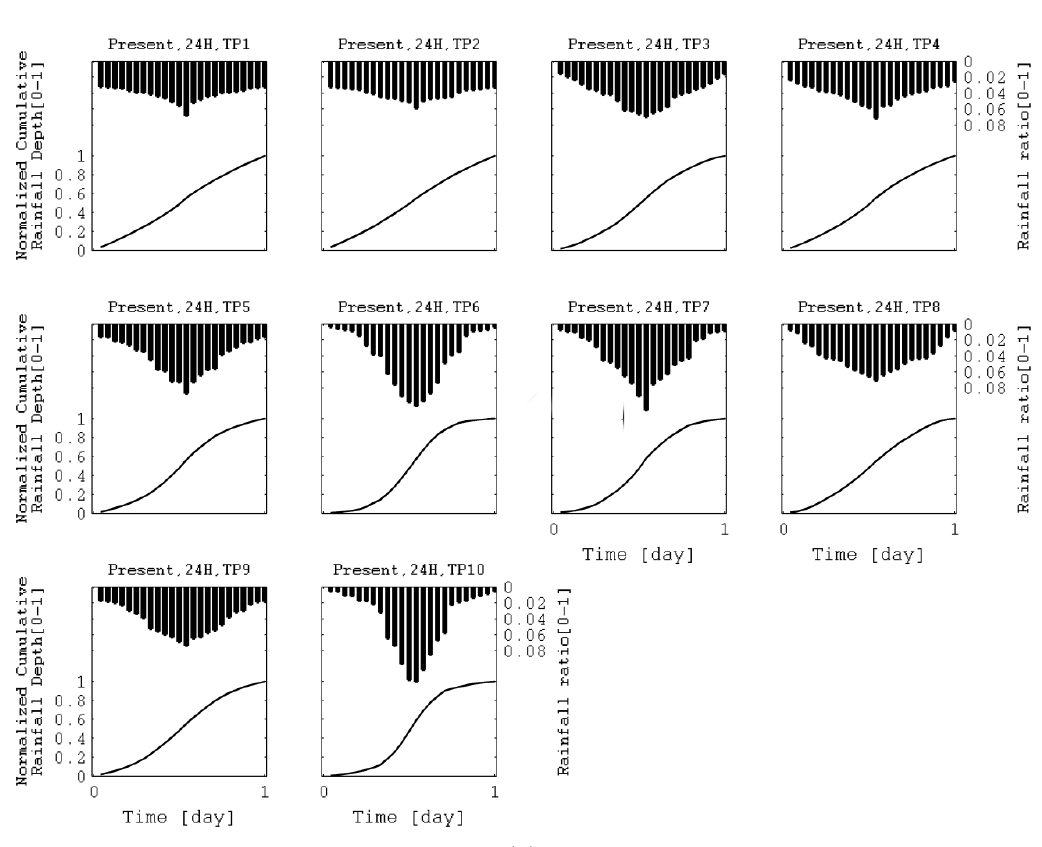
Figure 5. Present-term temporal distribution of normalized rainfall, averaged over the upper stream area from the dam inlet, from TP 1 to TP 10 for ( a ) 24-h; and ( b ) 72-h periods without the modified ranking method